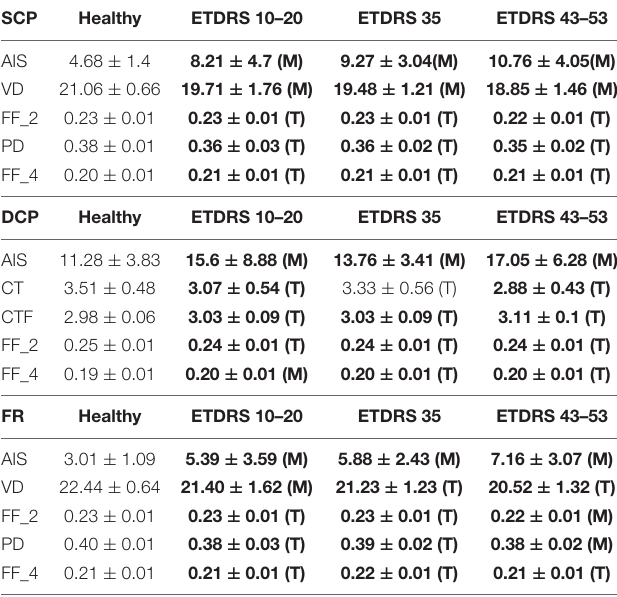
TABLE 2 | Mean and standard deviation of the top five vessel closure (VC) metrics for the superficial capillary plexus (SCP) in the control group and eyes with DR by Early Treatment for Diabetic Retinopathy Study (ETDRS)